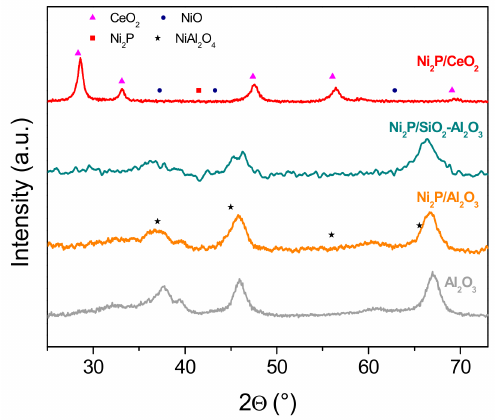
Figure 2. XRD diffractograms obtained for the catalysts’ series.